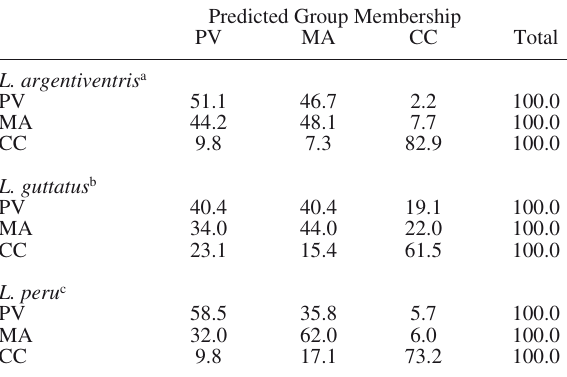
Table 2. – Classification results a,b,c of discriminant analysis of fish scale shape for the three geographic variants (PV, Puerto Val- larta; MA, Manzanillo; and CC, Caleta de Campos). Total clas- sification success for cross-validated predicted geographic variant